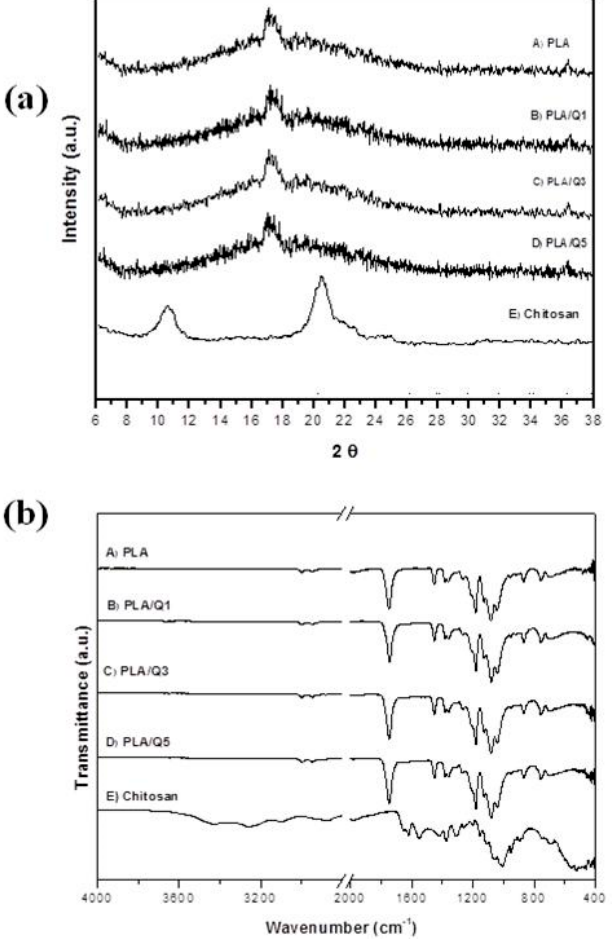
Figure 3. ( a ) X-ray diffraction patterns and ( b ) FT-IR spectra of A) PLA; PLA/chitosan composites with B) 1 wt % (PLA/Q1), C) 3 wt % (PLA/Q3), D) 5 wt % (PLA/Q5) chitosan, and E)